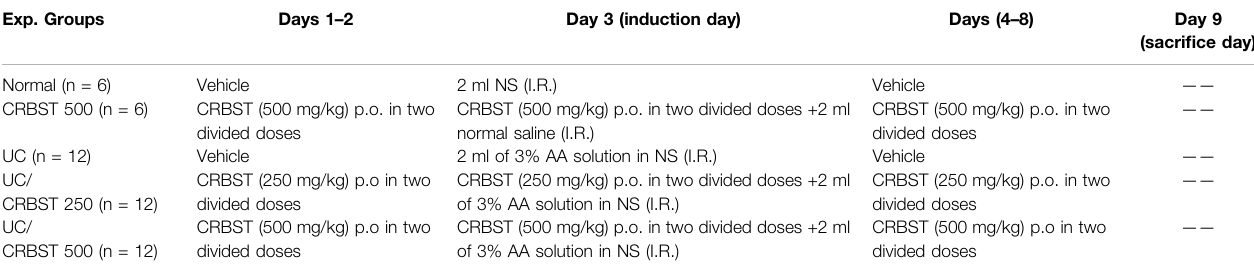
TABLE 1 | Experimental design and treatment protocol.